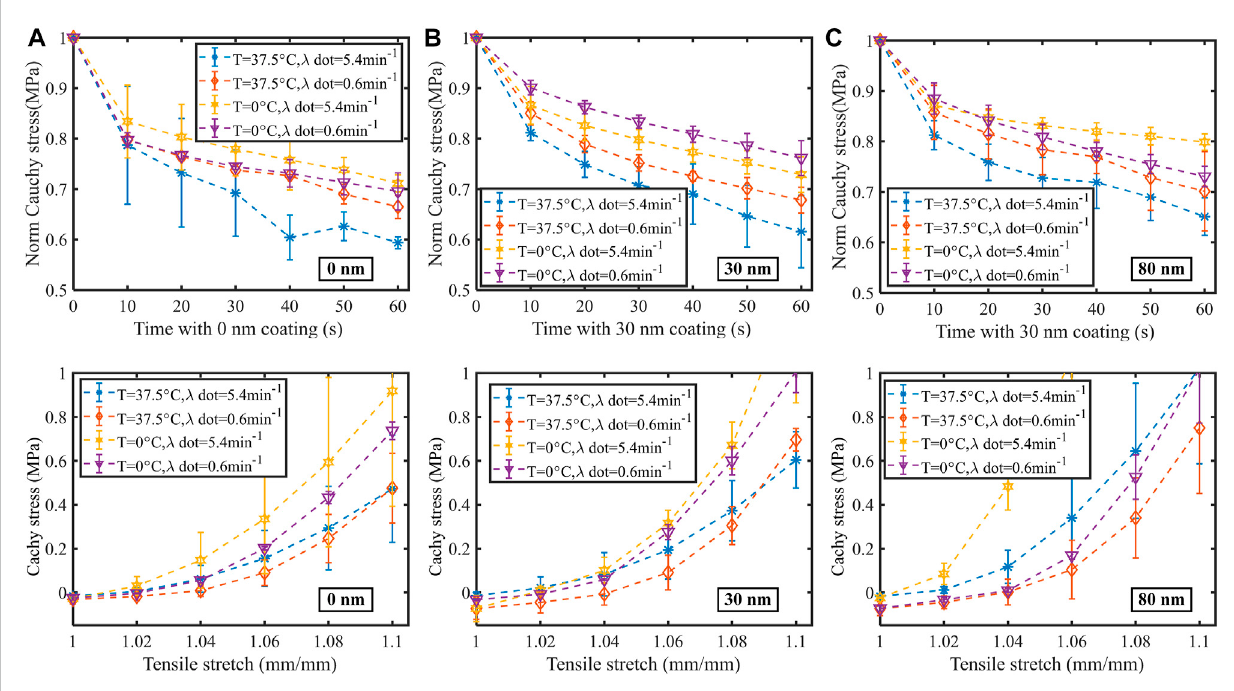
FIGURE 3 Stress relaxation and uniaxial tensile mechanical data of polypropylene patch coated with 0, 30, and 80 nm thickness of titanium are provided out through (A – C) . The effect of two ambient temperatures (0 ° C and 37.5 ° C) and two loading strain rates (6 and 54 mm/min) on changing the visco- hyperelasticity properties of the strips is investigated. All plots show how the mechanical properties of the strips vary with the different coatings. The fi rst row shows the measured data for strip relaxation. Meanwhile, the second row shows the measured data for strip stretching. Each row shows a different coating thickness. The data are shown as dashed lines with error bars, indicating the visco-hyperelasticity mechanical properties under the respective conditions. The data curves fully compare the effect of temperature and strain rate on the visco-hyperelasticity of the